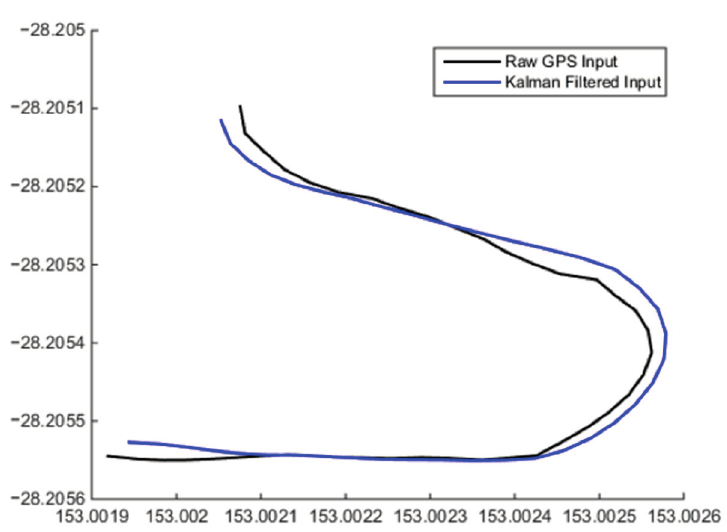
Figure 2. The increased precision of the input GPS coordinates after application of a Kalman filter to produce a more realistic human movement